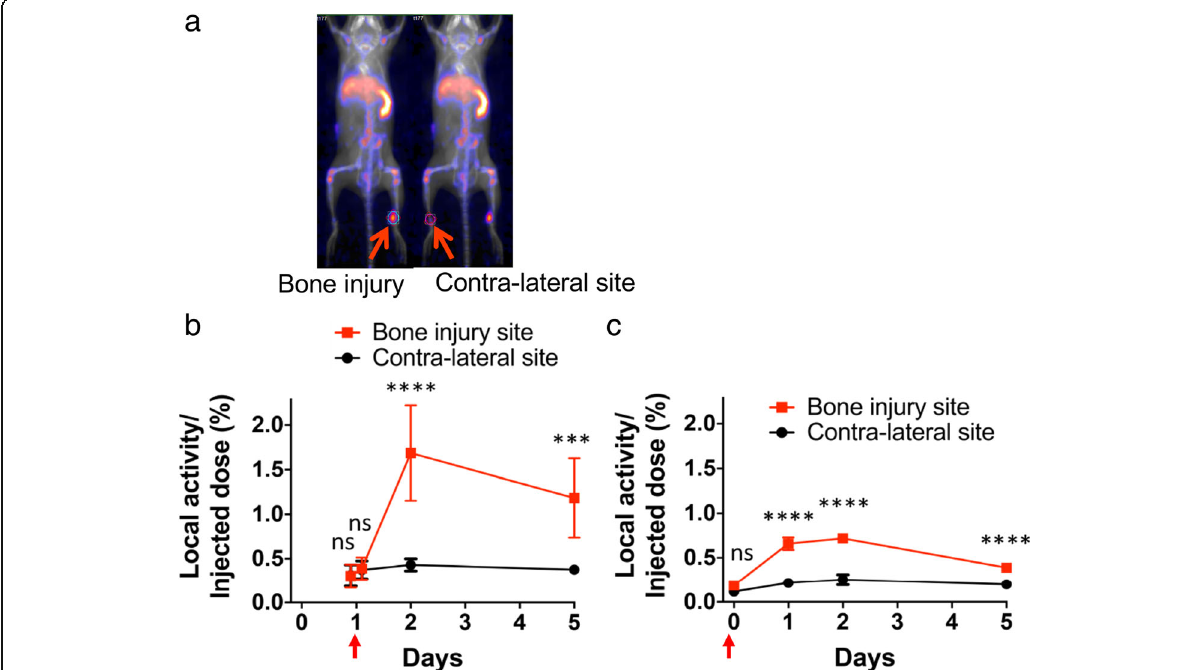
Fig. 2 Quantitation of microPET imaging reveals BM trafficking kinetics to the bone injury site. The percentage of 89 Zr activity accumulated at the fracture site was quantified by setting a volume of interest on the acquired PET/CT images ( a ) and correcting for radioactive decay. As an internal control, 89 Zr activity in the contralateral tibia was quantified. The BM cells highly accumulated at the fracture 1 day after the fracture generation in both the day 1-fracture ( b ) and day 0-fracture ( c ) schemes and gradually decreased thereafter. The BM cells preferentially accumulated at the fracture site compared to the contralateral control in both fracture models 1 day after the fracture generation ( n =4 in each group, **** p <0.0001 and *** p <0.001 with two-way repeated measure analysis of variance (ANOVA) with Sidak ’ s multiple comparisons test. The arrows indicate the timing